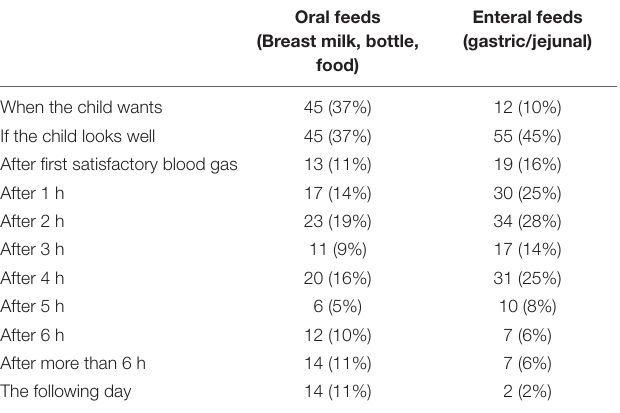
TABLE 2 | Oral/Enteral feeding re-introduction after extubation in PICUs.